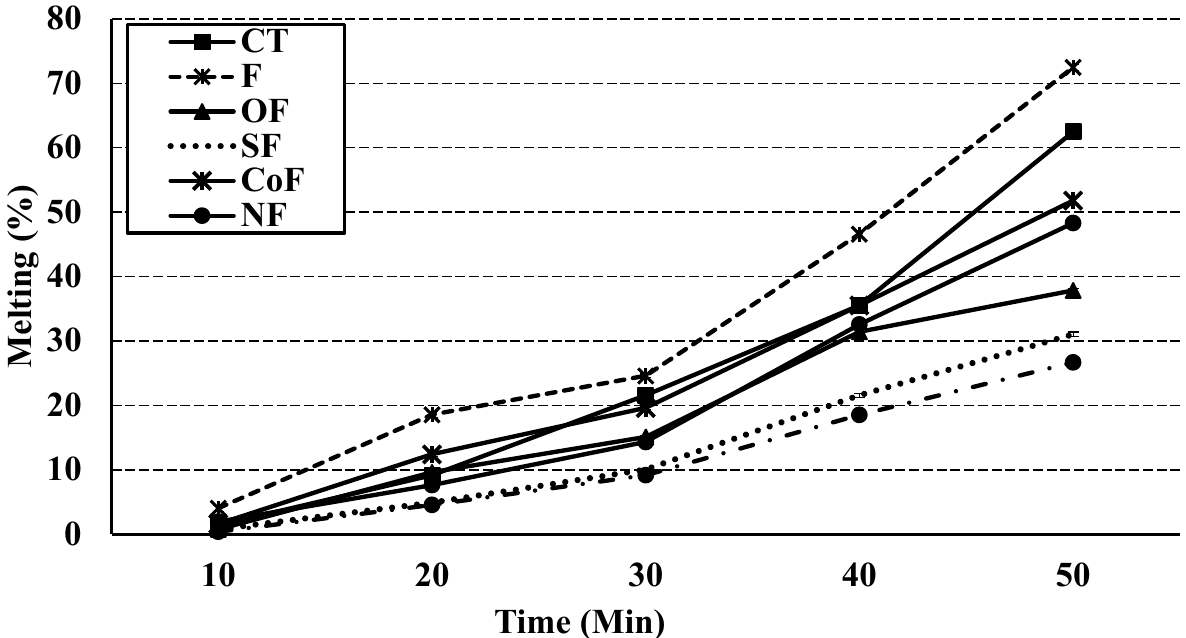
Figure 2. Melting rate of frozen yoghurt as affected by using chufa milk and different flavoring materials (Mean ± SE of 3 replicates). Refer to Materials and Methods for treatment